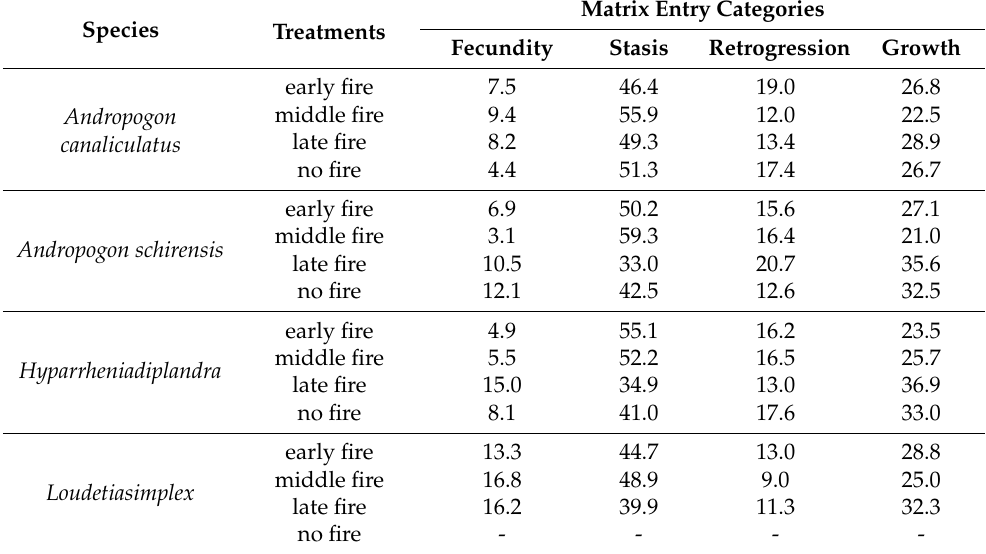
Table 4. Elasticity as the contribution (%) of fecundity, stasis, retrogression and growth to the λ s of all species under each fire treatment. The (-) denote that there was no value for L. simplex in the no-fire